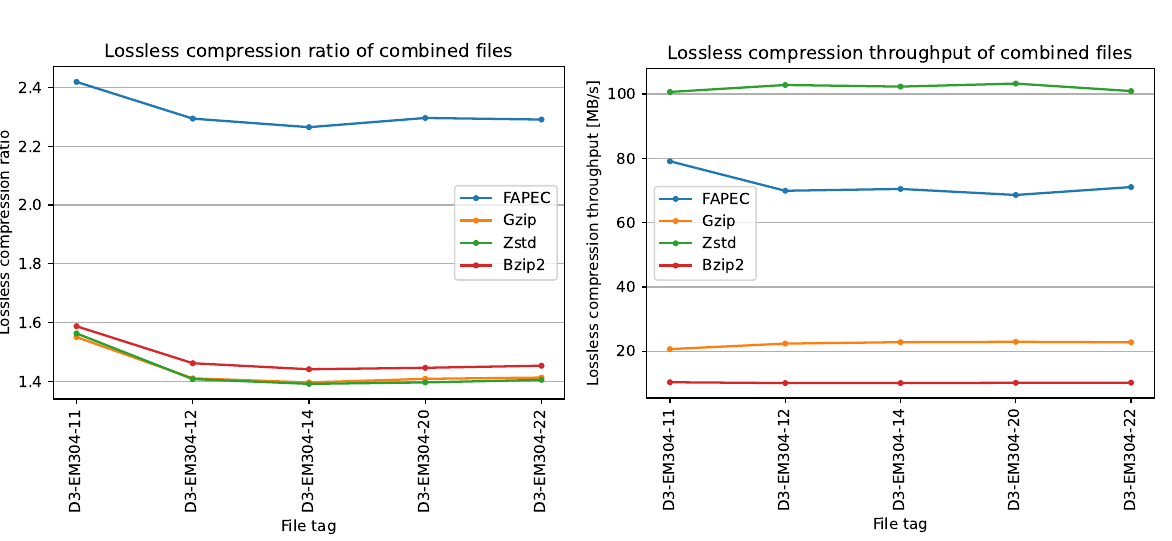
Figure 13. Lossless compression ratio ( left panel) and lossless compression throughput ( right panel) for the tested KMALL combined